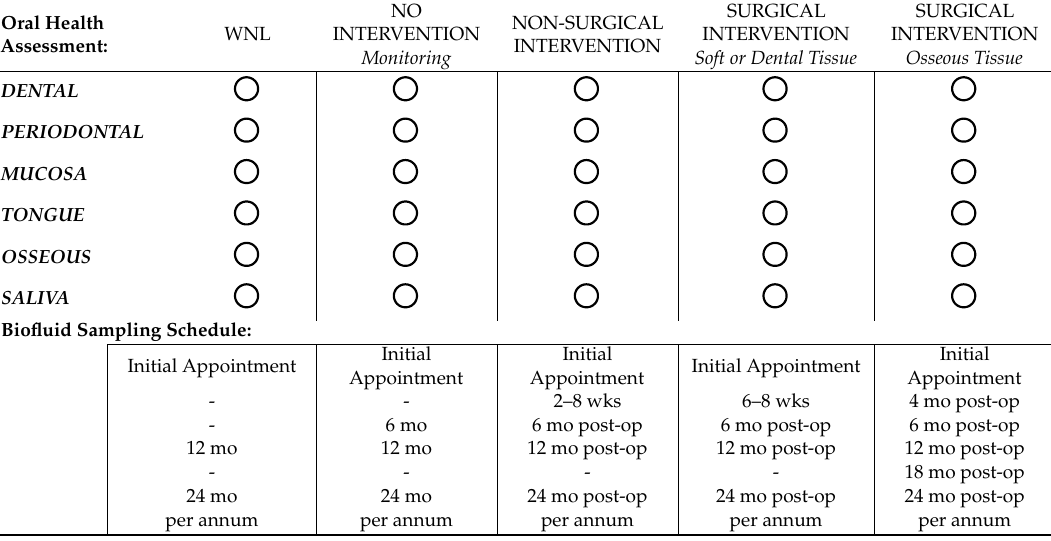
Table 2. Proposed oral biofluid sampling schedule . WNL, within normal limits.